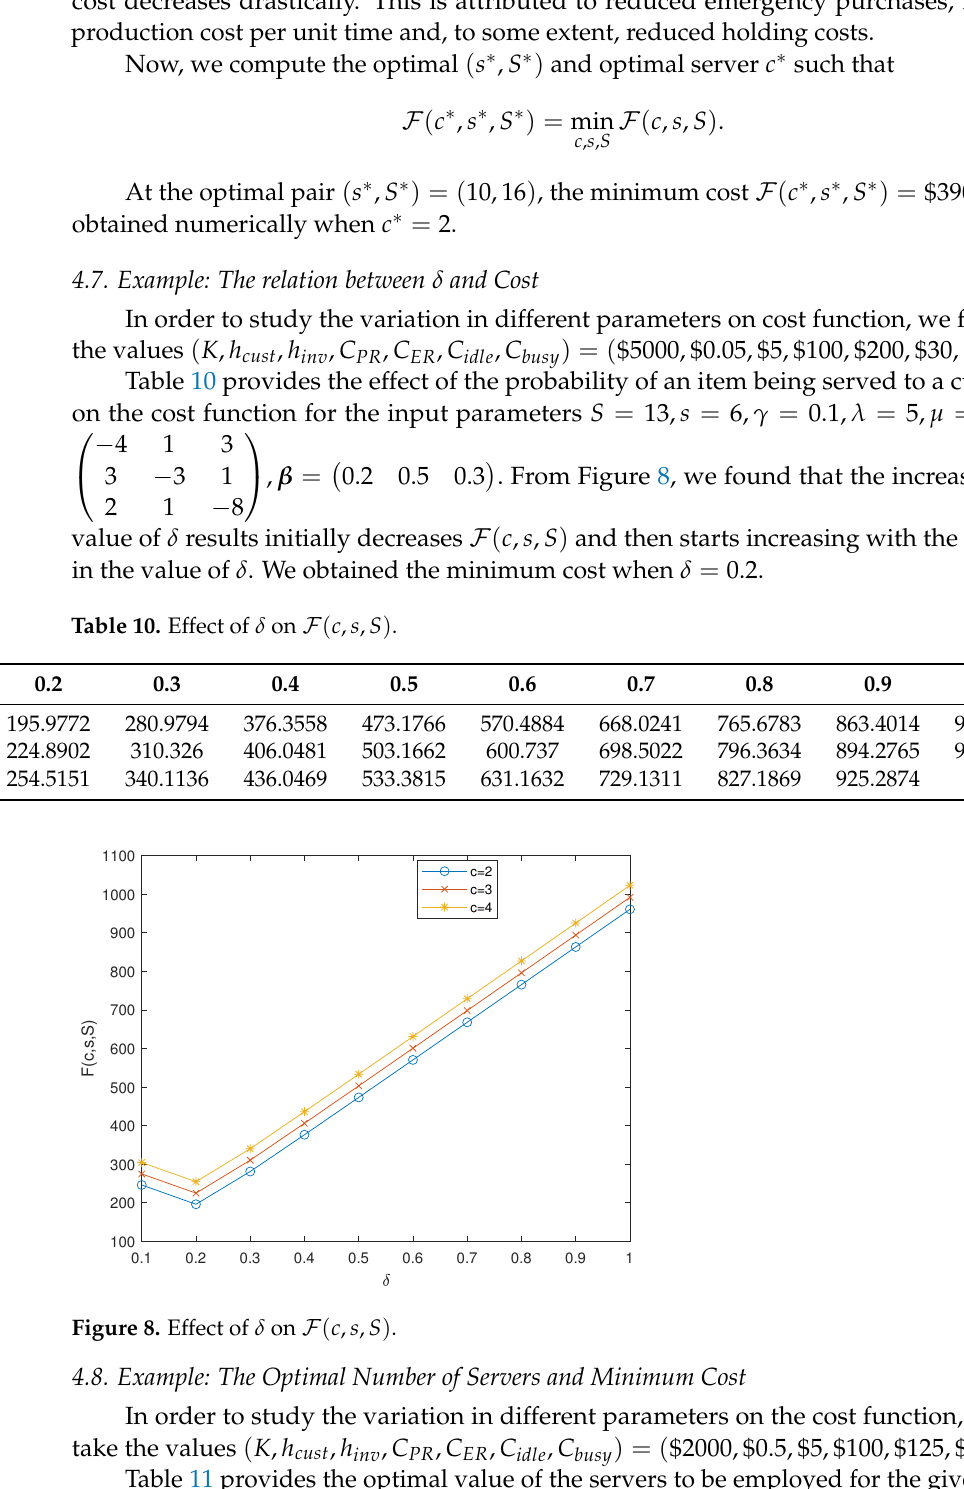
Figure 8. Effect of δ on